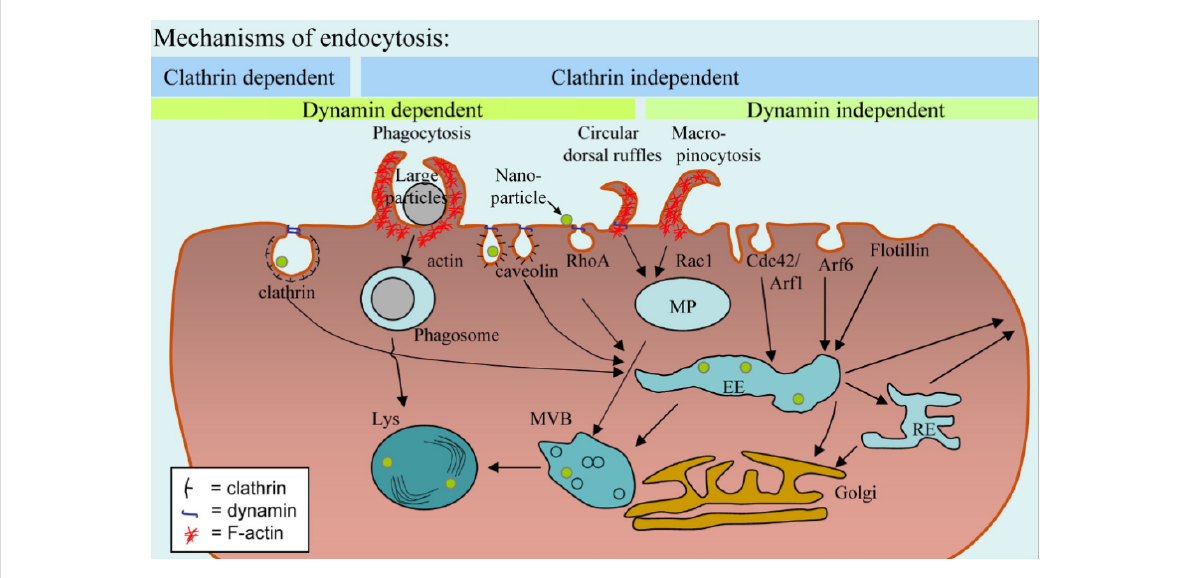
Figure 3: Scheme depicting the different mechanisms of cellular endocytosis. Reproduced with permission from [41]. Copyright (2011) Elsevier.